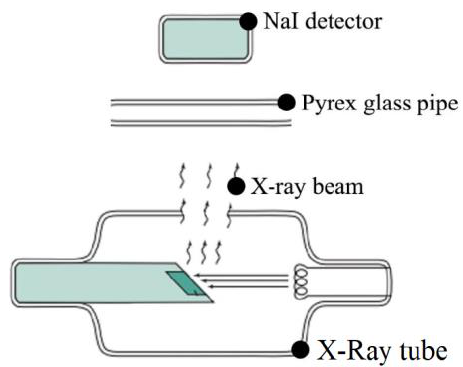
Figure 2. Proposed detection system structure.